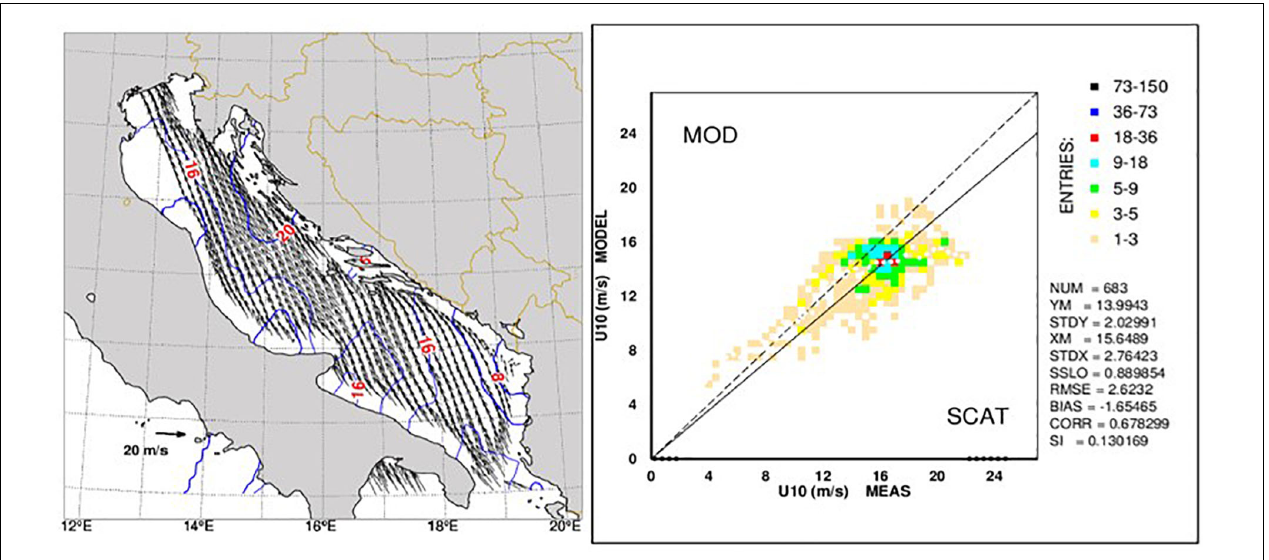
FIGURE 10 | Wind field derived from ASCAT-B scatterometer in the evening of 29th October, 2018 over the Adriatic Sea pilot (left) , and comparison between modeled and measured wind speed values for that event (right) .